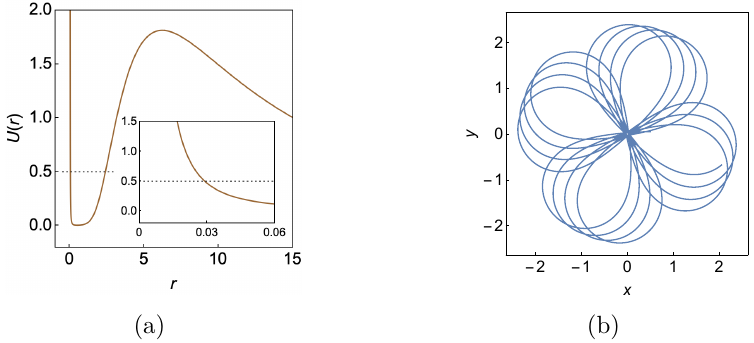
Figure 11 . An example of a bound state for the nonlocal scalar theory with g = 100 , µ = 1 , ω = 2 , a = 1 , b = 0 . 1 , and t f = 100 : (a) effective potential; (b) the trajectory of the system in the xy